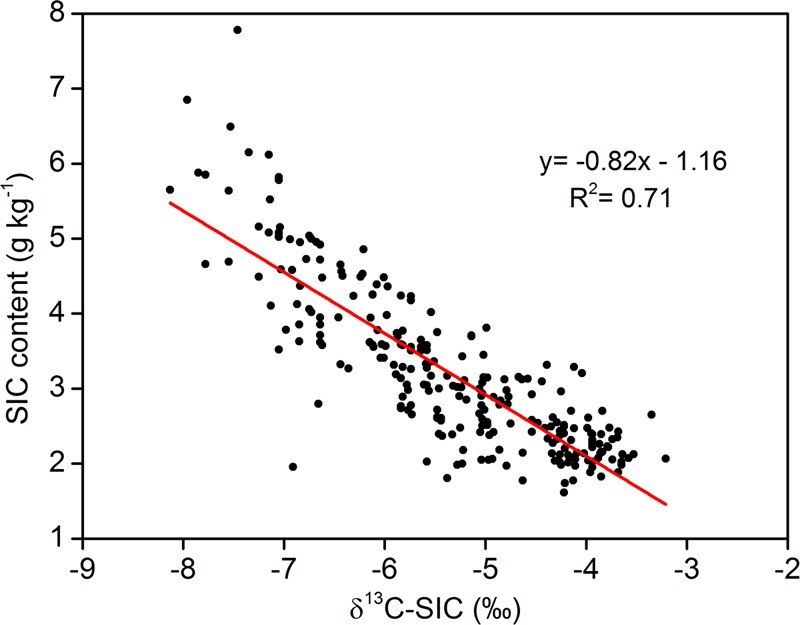
Relationship between soil inorganic δ13C value (δ13C-SIC) and inorganic carbon (SIC) contents (using all 260 samples within 0–100 cm depth from four sample plots). Significance of the linear regression was considered as P < 0.01.